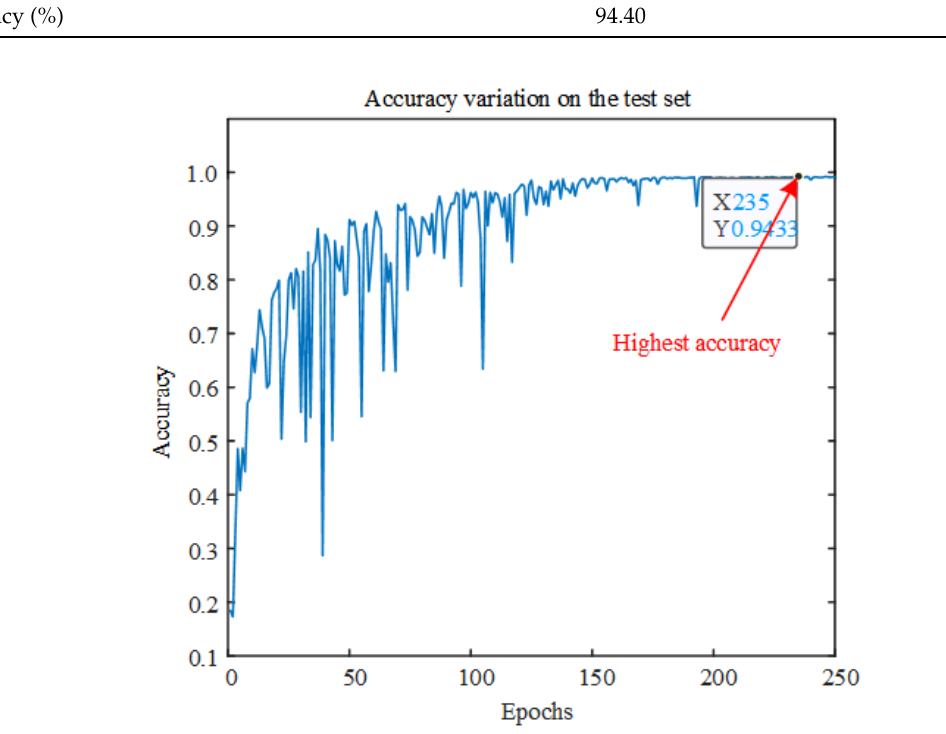
Figure 6. Test set accuracy on the CWRU dataset.